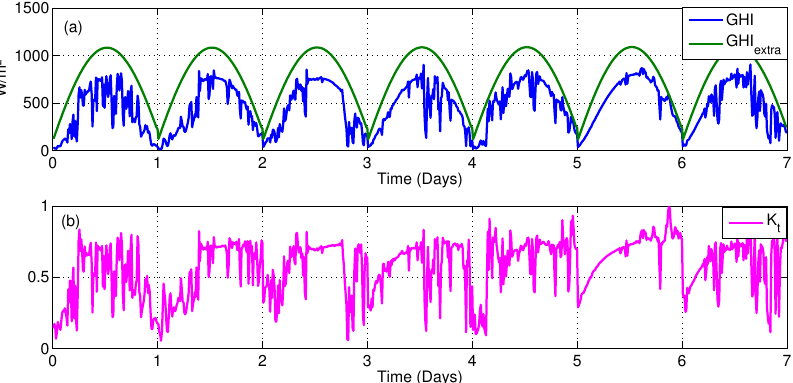
Figure 1. ( a ) Seven days of GHI data and the corresponding theoretical extraterrestrial model (GHI extra ). ( b ) The corresponding K t signal